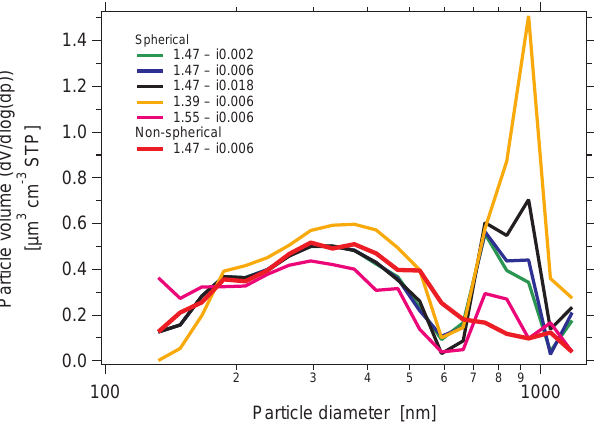
Figure 9. Particle volume distribution measured in the LMS dur- ing the CARIBIC flight LH339 on 19 April 2011 from Frankfurt, Germany, to Vancouver, Canada. Same data are displayed for six different refractive indices and using six different OPSS response